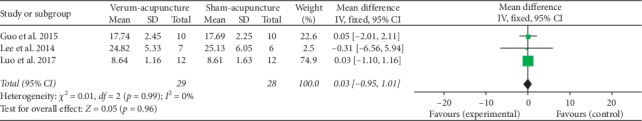
Forest plot of verum- versus sham-acupuncture in swimming speed.